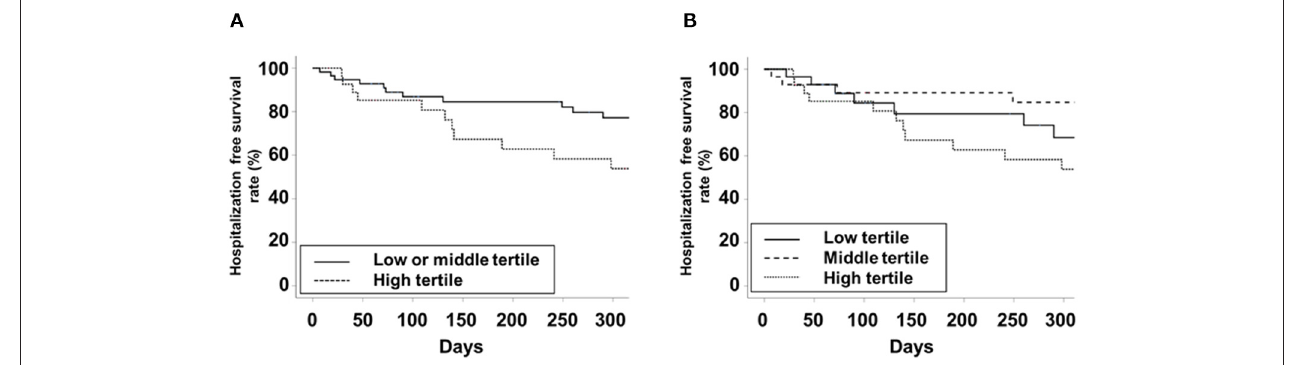
FIGURE 1 | Kaplan-Meier curve for hospitalization-free survival. (A) Low or middle vs. high tertiles. (B) low vs. middle vs. high tertiles.